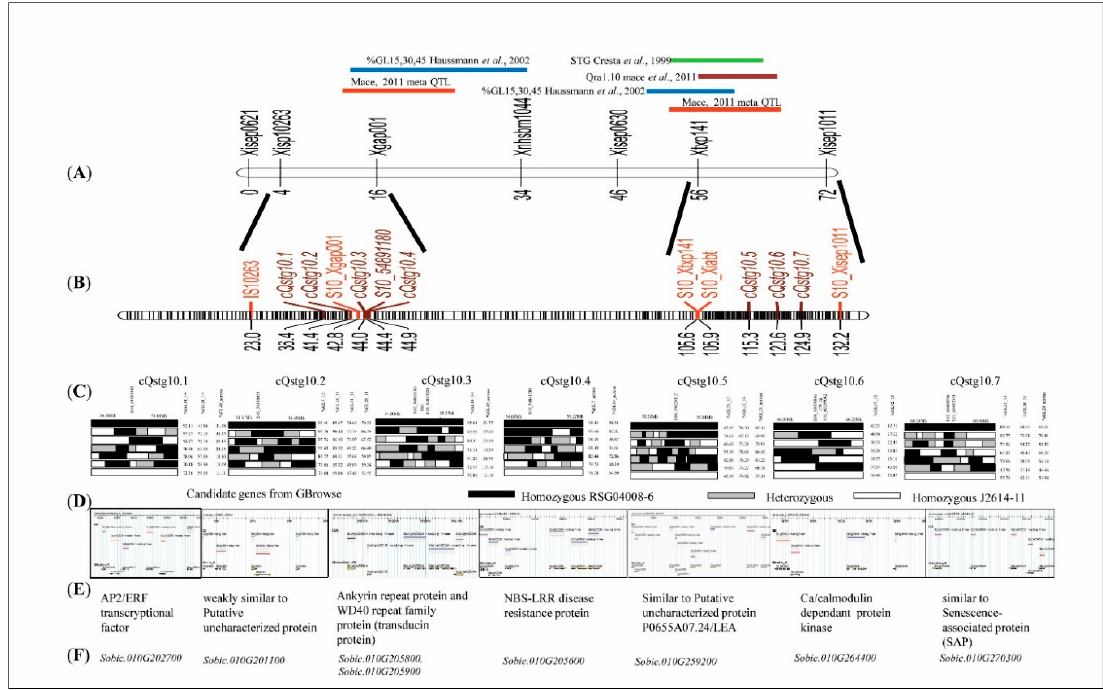
Figure 4. Fine-mapping of stay-green and GBrowse representation of candidate genes. ( A ) SSR map with overlapped stay-green and related QTLs from previous studies. ( B ) SSR integrated GBS–SNPs linkage map with clustered QTLs. ( C ) Across seasons percent green leaf area (%GL) data used to fine-map clustered stay-green QTLs and the putative candidate genes identified based on the variant SNPs. ( D ) Snapshot displaying G browse images showing the candidate genes present in the fine-mapped regions, ( E ) Functional annotation of the identified candidate genes. ( F ) Candidate gene ids for the Sorghum bicolor v3.1.